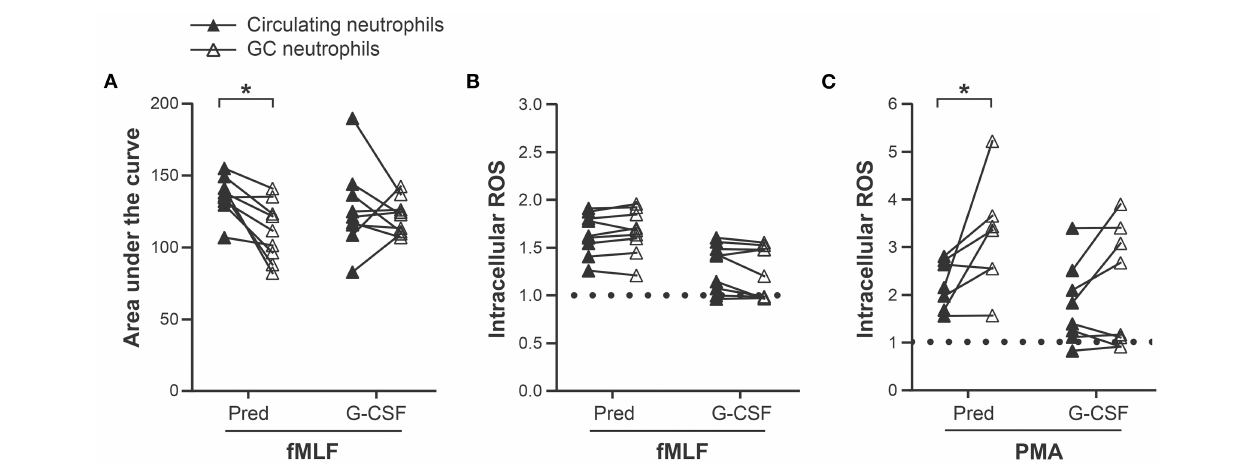
FIGURE 4 | Effect of leukapheresis on neutrophil responses. (A) Intracellular calcium levels measured with a spectrofluorometer after fMLF stimulation of circulating neutrophils (pre-leukapheresis) and prednisone and G-CSF GC neutrophils (post-leukapheresis) as described in “Materials and Methods.” (B) fMLF and (C) PMA-induced intracellular ROS production measured with CM- H2DCFDA in circulating neutrophils and prednisone and G-CSF GC neutrophils. The results are expressed as a MFI ratio of stimulated cells/cells incubated in DMSO (diluent). The dotted line represents the absence of increase in ROS production (ratio = 1). Statistical analysis: Sidak multiple comparison test performed to compare circulating neutrophils with GC neutrophils from prednisone- and G-CSF-pre-treated donors: * p -value < 0.05. These data are compiled from the analysis of 9 donors for the fMLF stimulation and 7 prednisone and 8 G-CSF GCs for the PMA stimulation.